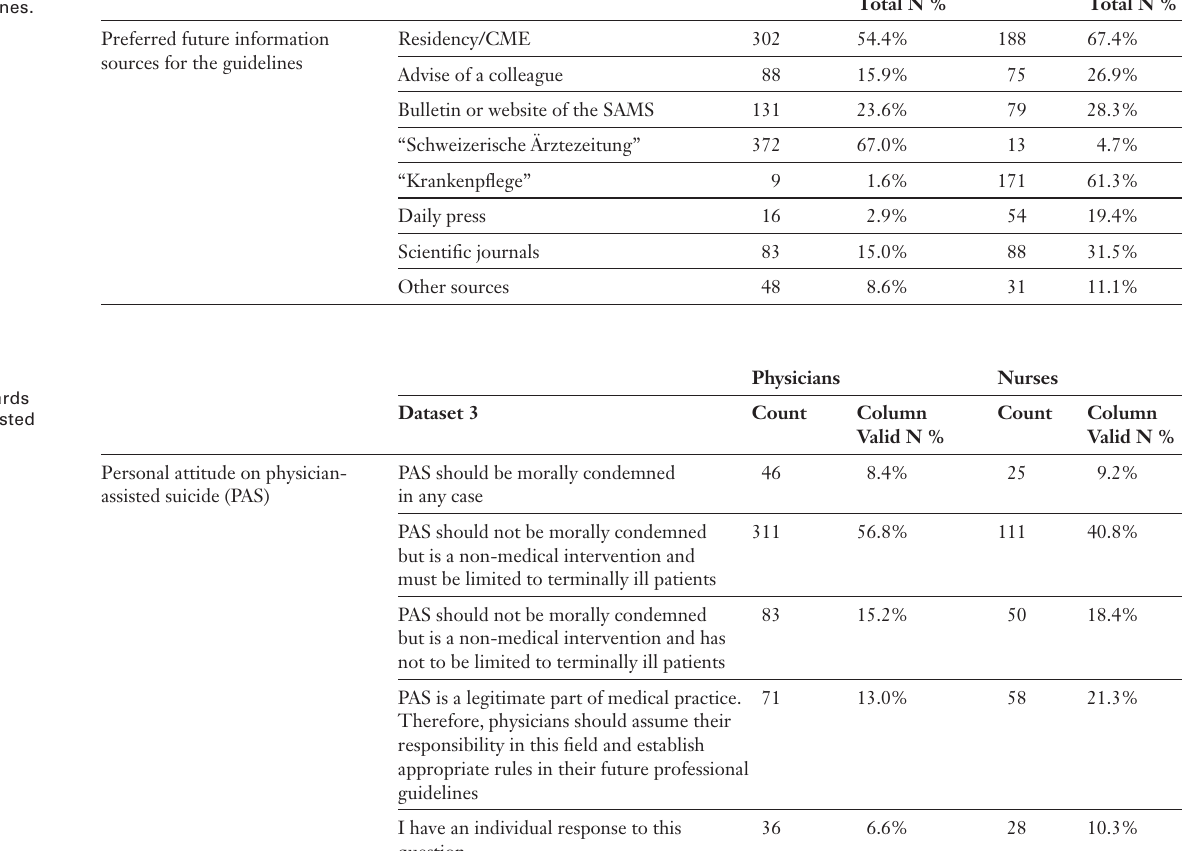
Table 8 Preferred future information sources for the guidelines.